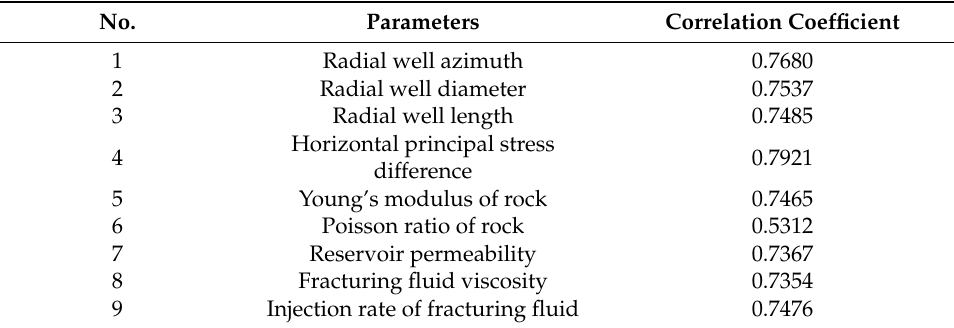
Table 2. Gray correlation coefficient corresponding to different